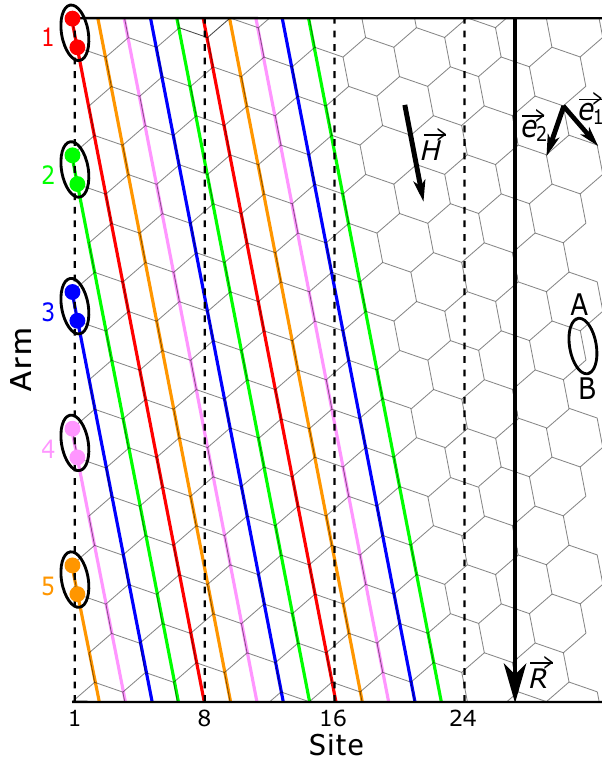
Fig. 2 Decomposition of the (5,10) CNT into a spiral of 5-arm sites. The CNT can be viewed as a piece of graphene rolled up along the ! lattice vector R ¼ 5 e ! 1 þ 10 e ! 2 ( e ! 1 and e ! 2 being the primitive lattice vectors). Each arm consists of two inequivalent carbon atoms, denoted as A and B . The 5 arms are highlighted by different colors. ! H is the primitive lattice vector along the spiral. The black dashed lines indicate different